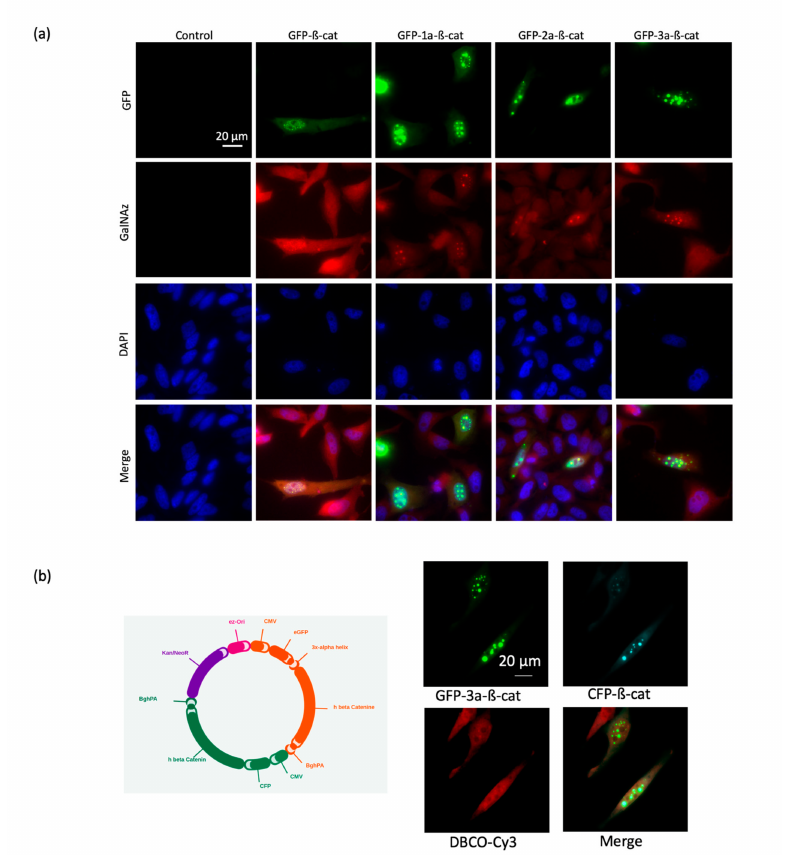
Figure 3. Evaluation of the GFP- β -catenin constructs via fluorescent microscopy. ( a ) Fluorescence images of HeLa cells expressing GFP-linker- β -catenins, treated with 200 µ M Ac 4 GalNAz and labeled with DBCO-cy3. ( b ) Fluorescence images of HeLa cells expressing GFP-3a- β -catenin and CFP- β -catenin, treated with 200 µ M Ac 4 GalNAz and labeled with 10 µ M DBCO-cy3. The map of the vector encoding both the GFP-3a- β -catenin and the CFP- β -catenin is shown on the left. CFP, cyan fluorescent